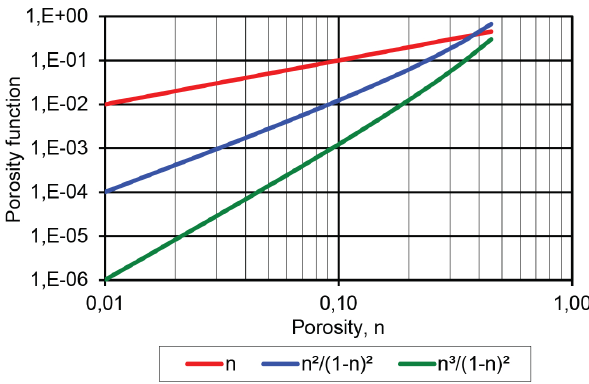
Figure 3. Effects of driving ( n ) and drag resistance ( n 2 /( 1 − n) 2 ) factors in the porosity function ( n 3 /( 1 − n) 2 )